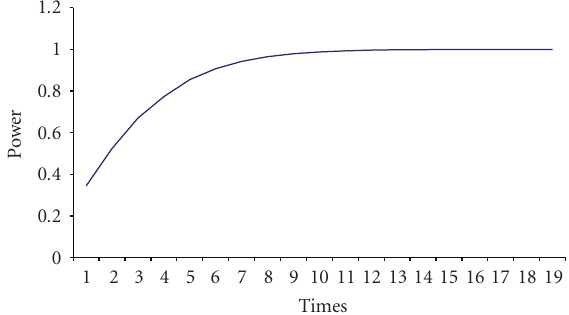
Figure 3: Power analysis under the longitudinal mixed model with heterogeneous compound symmetry variance structure.